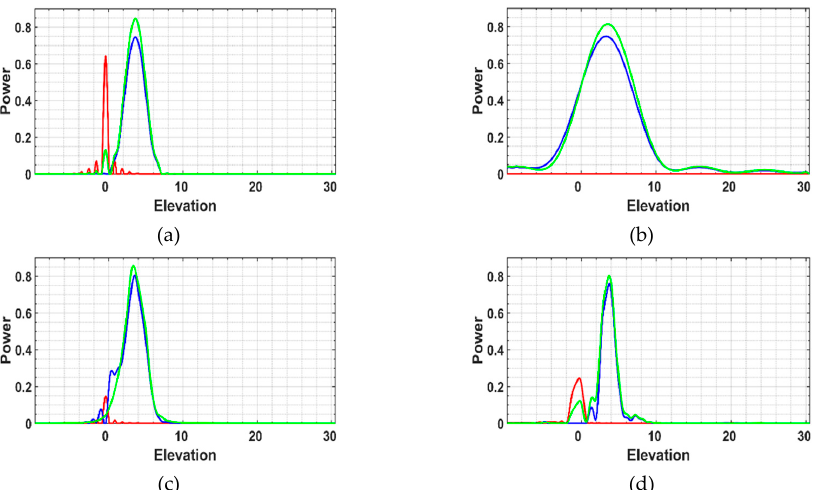
Figure 3. Extracted features from three-component decomposition of reconstructed T . ( a ) simulated, ( b ) Beamforming, ( c ) Capon, and ( d ) proposed method. Red, green and blue indicate the profiles of double bounce, volumetric and surface scattering mechanisms.